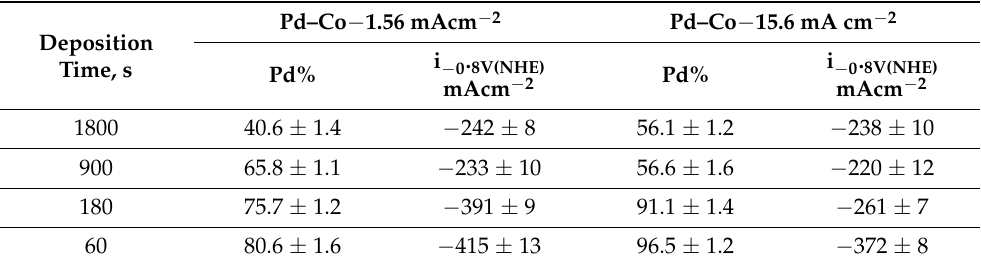
current density values for HER (mAcm − 2 ) at − 0.8 V/NHE obtained from CV carried out in 2 M H 2 SO 4 .